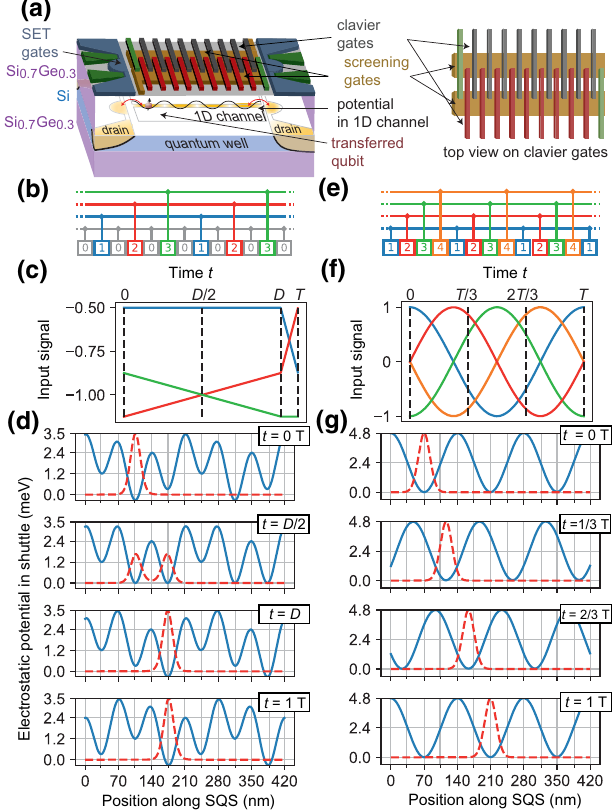
FIG. 2. SQS concept and operation modes. (a) Sketch of a SQS device. (b)–(g) Comparison of BB (left panels) and CB (right panels) transfer modes. (b),(e) Position of the clavier gates and electric connection scheme for the BB mode (b) and CB mode (e), respectively. (c),(f) Input voltages during a SQS step cycle T for the BB mode (c) and CB mode (f), respectively. (d),(g) Electrical potential (blue) calculated along the center of a SQS within the Si/SiGe quantum well for four time frames [dashed lines in (b) and (d) for each mode]. Dashed red line indicates the calculated electron